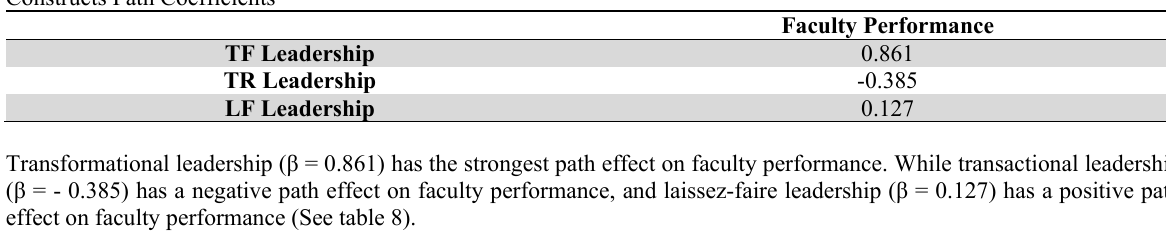
Constructs Path Coefficients TF Leadership 0.861 TR Leadership -0.385